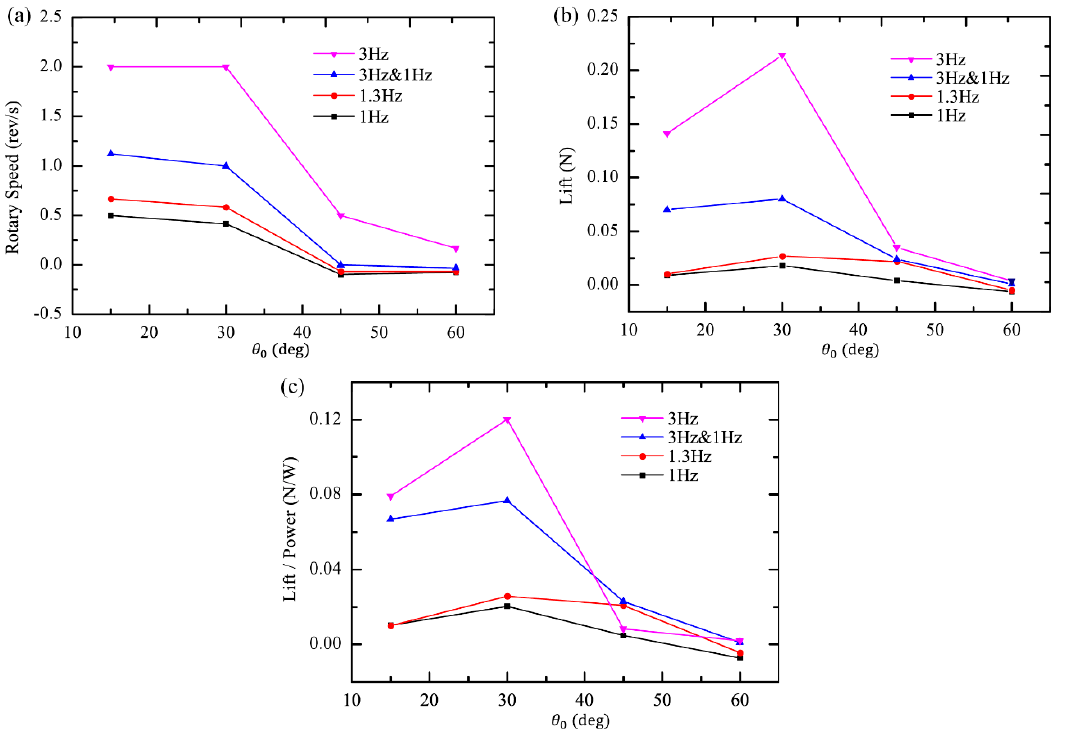
Figure 18. The ( a ) rotational speeds; ( b ) lift forces; ( c ) the ratio between lift and power produced by the FWR in different installation angles.